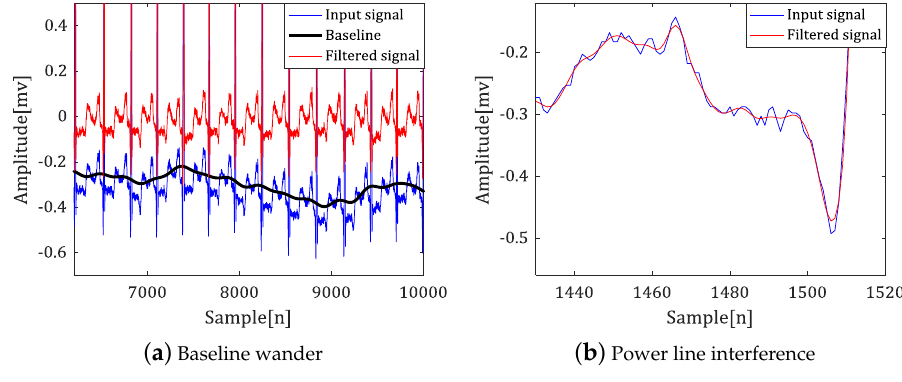
Figure 3. Noises of ECG signal and filtering